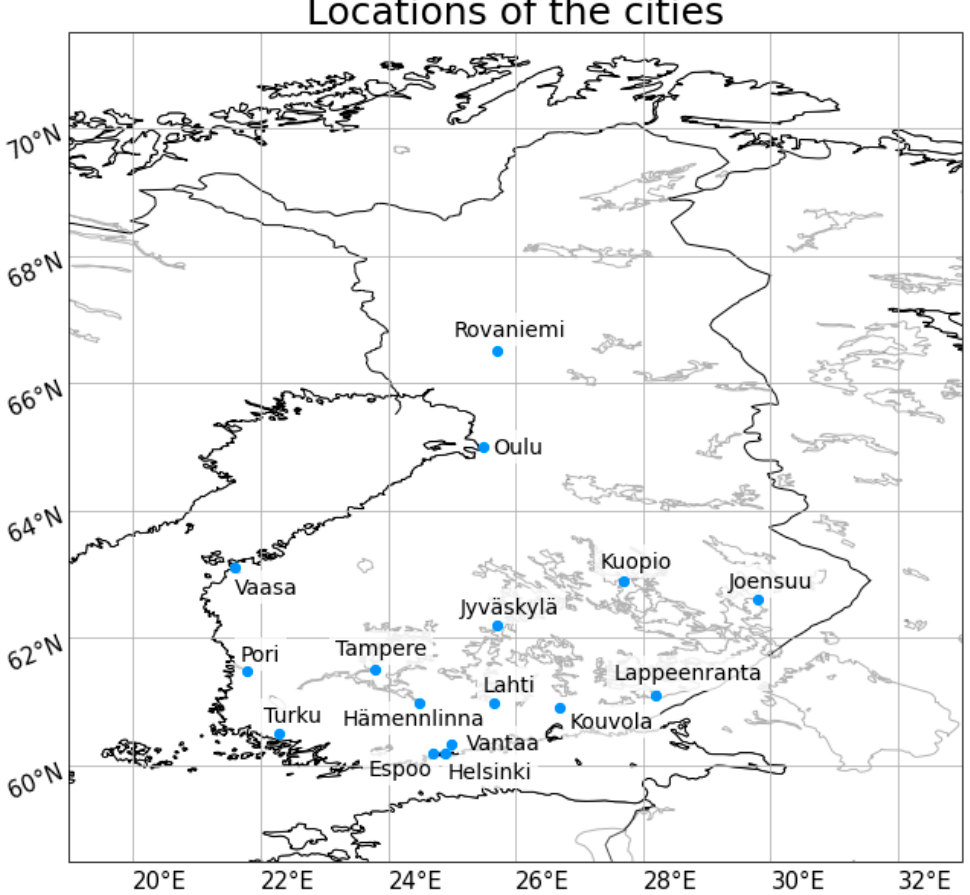
Figure 1. Location of the cities presented on the map.